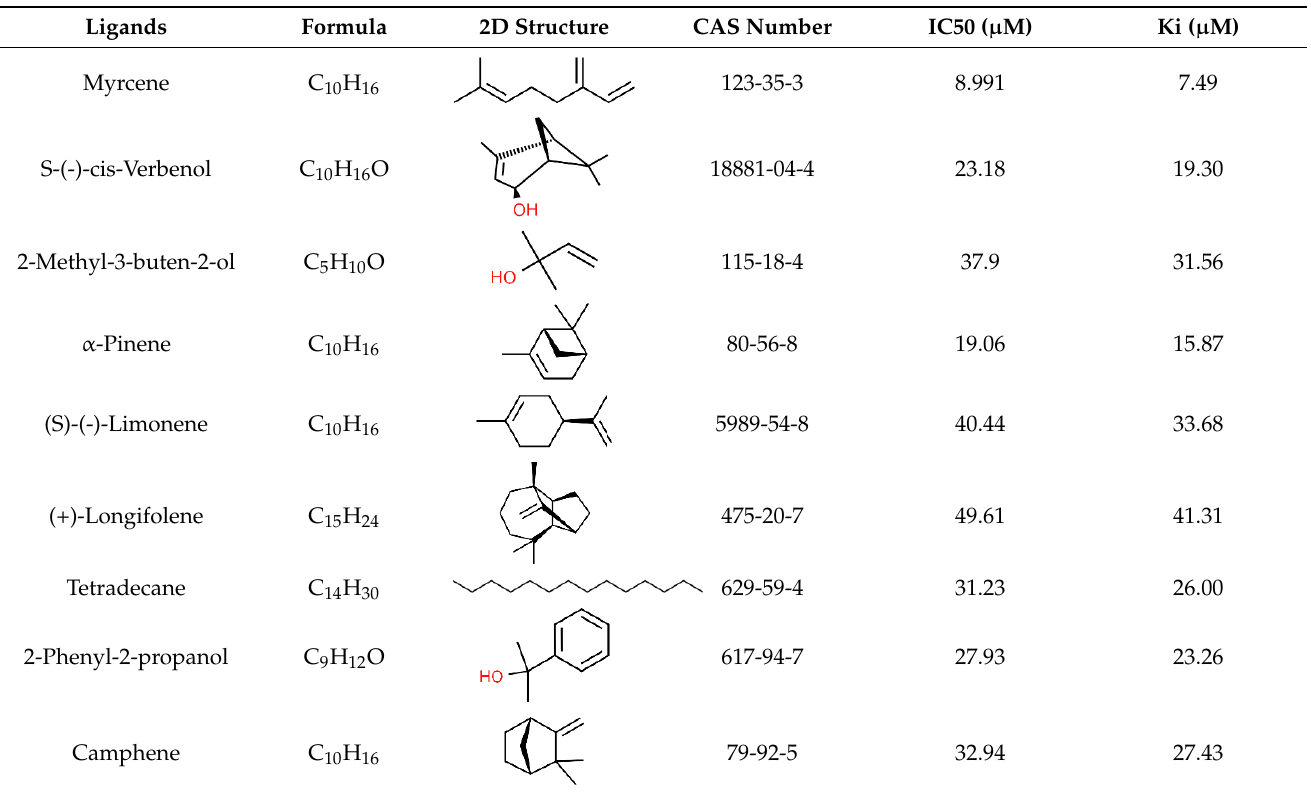
Figure 6. Competitive fluorescence ligand-binding assay of EparOBP2 to ligands. ( A ): Binding curve and relative Scatchard plot of EparOBP2 and 1-NPN. ( B ): Competitive binding curves of EparOBP2 with nine ligands. Table 1. Binding affinities of different ligands to EparOBP2.